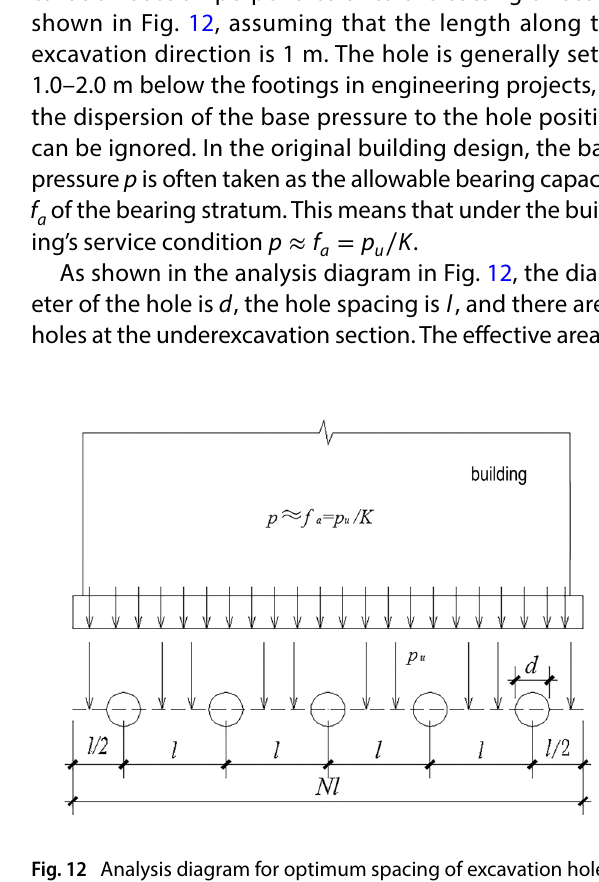
Fig. 12 Analysis diagram for optimum spacing of excavation